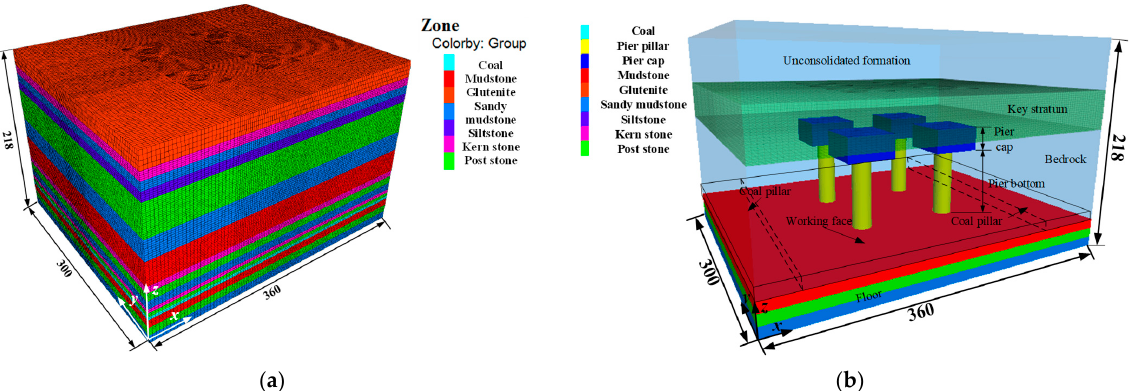
Figure 4. Numerical simulation of multi-arch pier-column backfilling and support model: ( a ) FLAC 3D numerical simulation; ( b ) backfilling and support model.